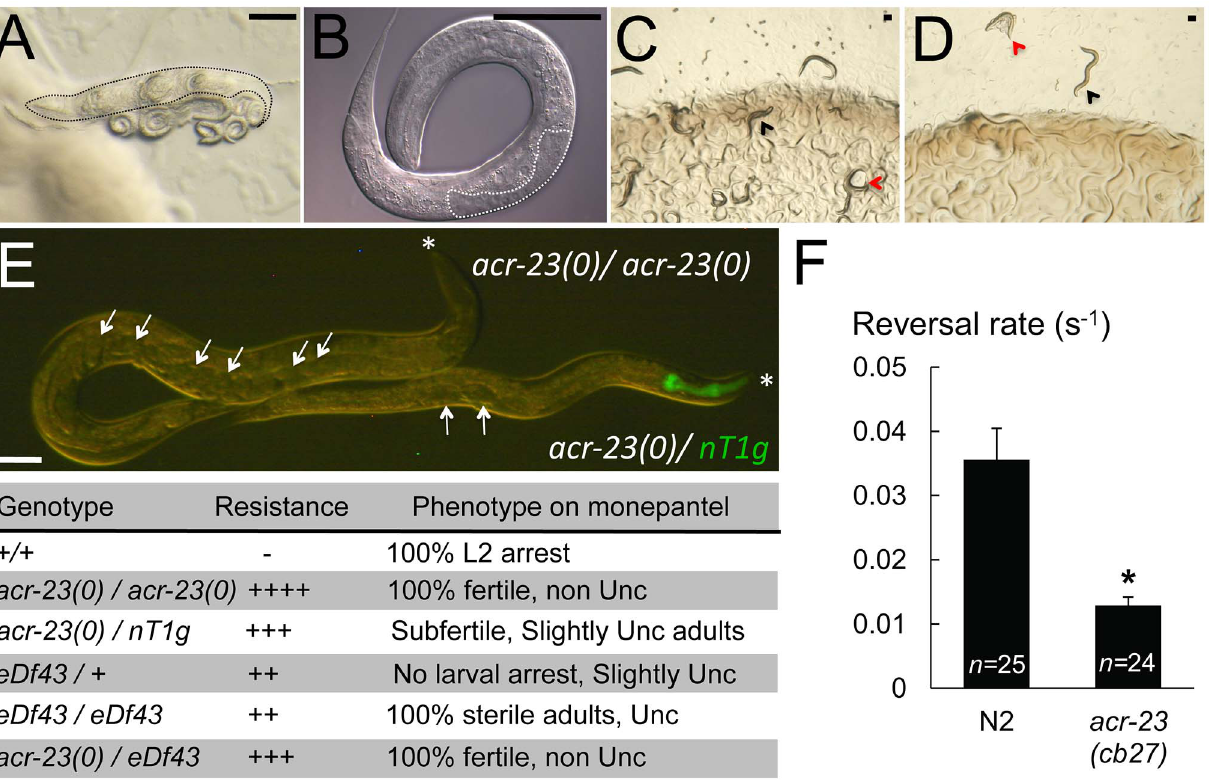
Figure 1. Effects of monepantel on C.elegans and rescue of mutant acr-23 . A) Adult N2 hermaphrodite with hatched embryos on 60 m M monepantel. L1 and L2 larvae are paralyzed and coiled (carcass of mother is outlined). B) Higher resolution of an arrested L2 larva. The germline is outlined. C) acr-23 ( cb27 ) animals carrying an extrachromosomal array containing wild-type acr-23 grown on standard NGM. Transgenic animals have a rolling phenotype (red arrowhead; non transgenic worms are denoted by a black arrowhead in C and D). D) In presence of monepantel, only non- rolling siblings are mobile and fertile. Transgenic animals are immobilized and dying or dead. Panels C) and D) show plates with the progeny of one single rolling parent incubated for 6 days at 20 u C. E) Phenotypes of homozygotic and heterozygotic acr-23(cb27). eDf43 is a deficiency that spans acr- 23 and neighboring genes. Depicted adult worms are one heterozygote, with dominant pharyngeal GFP expression ( nT1g ), and one non-glowing acr- 23(cb27) homozygote, both grown on 20 m M monepantel. White arrows indicate all embryos present in the uterus. Similar results were obtained with acr-23(ok2804)/nT1g heterozygotes (not shown). Asterisks indicate the head. Bar, 50 m m. F) acr-23 mutants make fewer reversals. The rate of reversal events, where worms shift from forward to backward locomotion or vice versa, was measured in starved worms crawling on food-free NGM plates at 20 u C. n is the number of movies analyzed, each tracking 15 to 60 individuals over at least 1 minute. *, P-value=6.4E-5 versus N2 by Student’s T-test (two-tailed). Results are expressed as mean with s.e.m as error